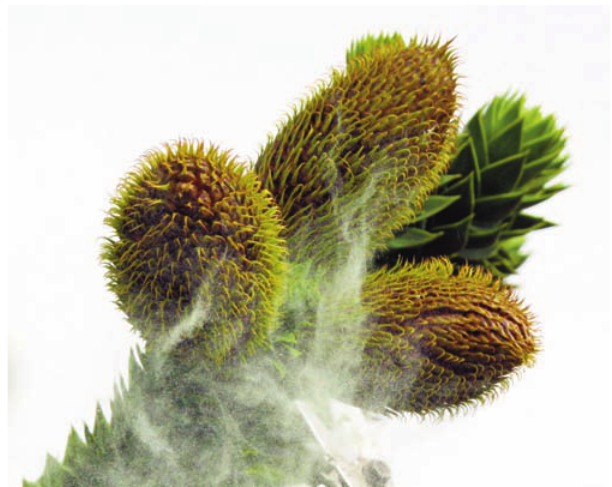
Fig. 3 - Araucaria araucana mature catkins during pollination.